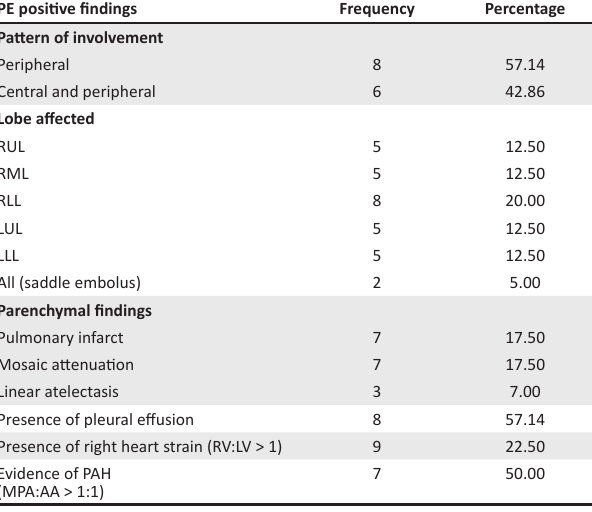
TABLE 2 : CTPA findings in pulmonary embolism positive cases.